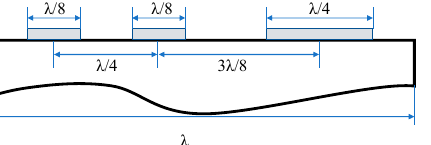
Figure 1. The geometrical configuration of an EWC-SPUDT cell.